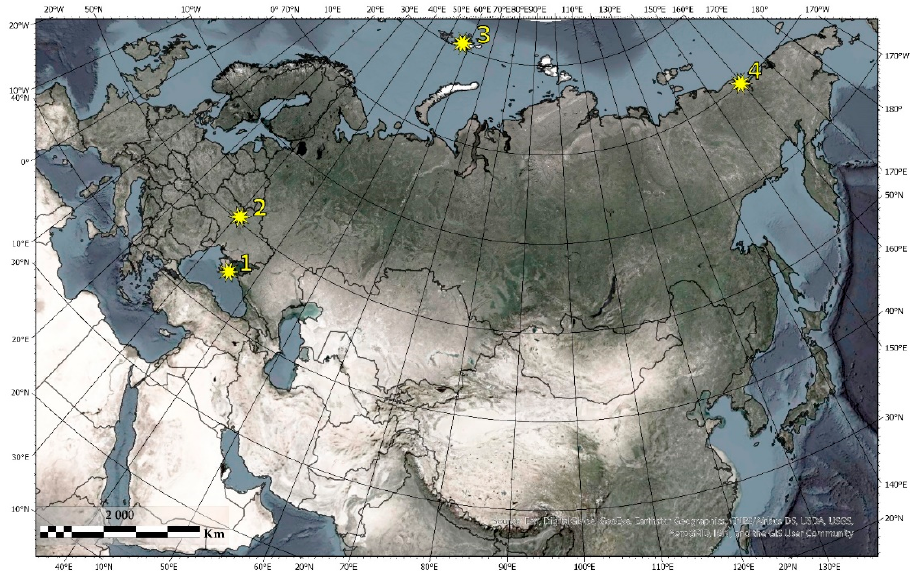
Figure 1. Map of sampling sites. See Table 1 for the description of the sampling sites (1–4). The processed samples were kept at 22°C in the dark and observed for 10 days to reveal the hidden species diversity [31]. To obtain clonal cultures, the individual heliozoan cells were transferred using a glass micropipette onto Petri dish containing a clonal cul- ture of eukaryotic prey. The prey cultures of flagellates Parabodo caudatus (Dujardin 1841) Moreira et al., 2004 (strain BAS-1, IBIW RAS) or Bodo saltans Ehrenberg 1832 (strain Pl-1, IBIW RAS) were grown in mineral water (Aqua Minerale, PepsiCo, Inc., Moscow oblast, Russia).